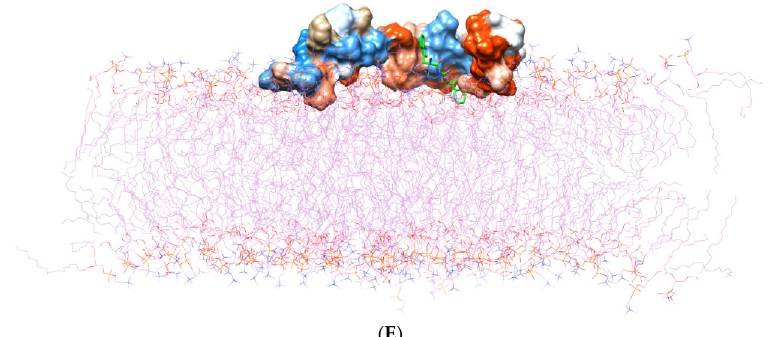
Figure 2. ( A ) Three domains of the A β 1–42 monomer: the hydrophilic N-terminal domain, the middle domain (called the central hydrophobic cluster (CHC)), and the hydrophobic C-terminal domain. The A β 1–42 monomer is colored in surface representation according to the hydrophobicity of the surface, from blue for the most hydrophilic, to white for zero, and to orange for the most hydrophobic. The post-MD simulation binding positions of ( B ) TGN1, ( C ) TGN2, ( D ) TGN3, and ( E ) TGN4 on the A β 1–42 monomer surfaces and on/in the POPC bilayer (wire representation) are shown. Ligands are shown in green .